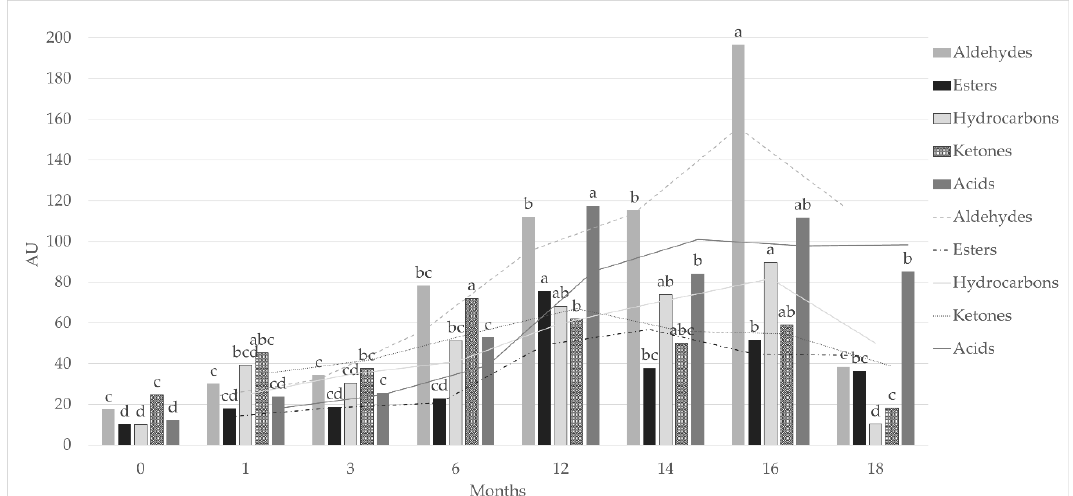
Figure 1. Total amounts of aldehydes, ketones, esters and hydrocarbons from R0 to S18 Toscano dry-cured hams. AU = Abundance units. Different letters (a, b, c, d) within the same chemical family indicate significant differences ( p < 0.05) among maturing times.